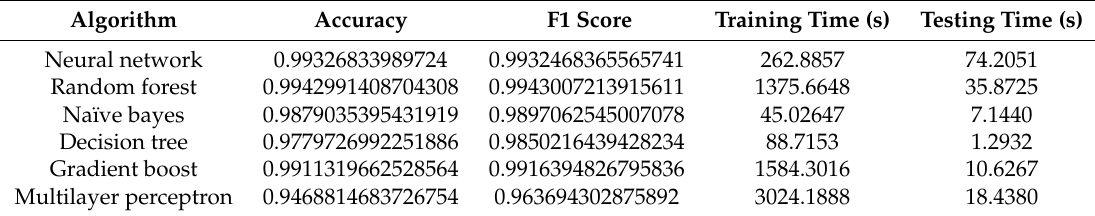
Table 5. Obtained results from the MQTT